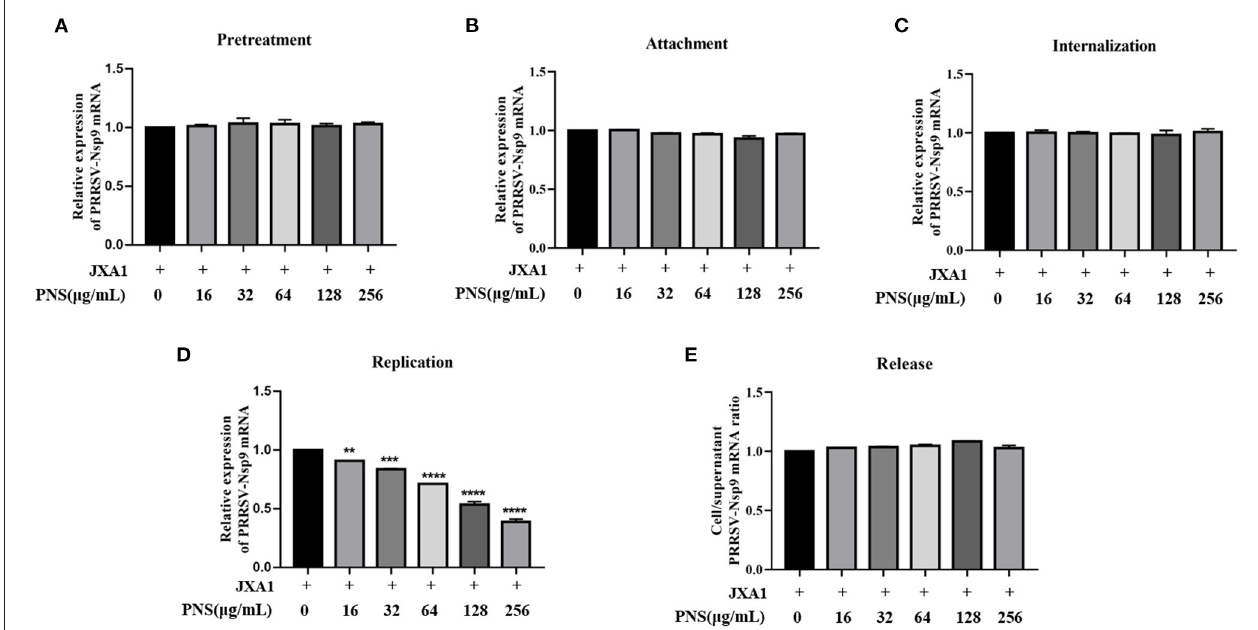
FIGURE 2 | PNS inhibits PRRSV replication. (A) Pre-treatment assay. Marc-145 cells were pretreated with 0, 10, 16, 32, 64, 128, 256 µ g/mL PNS for 2h, then, cells were washed with precooled PBS prior to PRRSV JXA1 (MOI of 0.05 TCID 50 per cell) addition, and then supernatant and cells were collected 48 hpi to detect Nsp9 mRNA expression levels. (B) Attachment assay. Marc-145 cells were prechilled at 4 ◦ C for 1h and then the media were replaced by a mixture of various concentrations of PNS and PRRSV (MOI of 0.05 TCID 50 per cell). After being incubated at 4 ◦ C for an additional 2h, the cells were washed with precooled PBS,